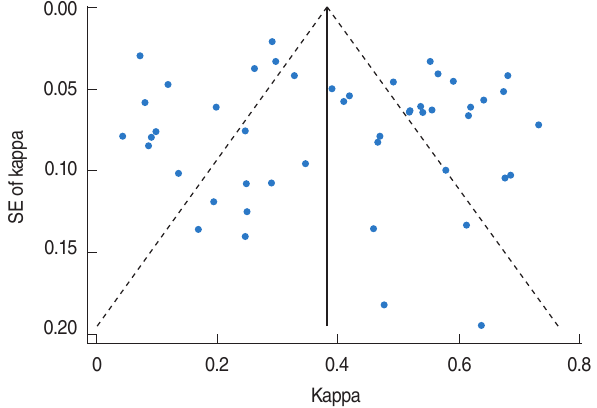
Figure 3. Funnel plot, using data from included studies in meta- analysis, with kappa displayed on the horizontal axis and SE (kap- pa) on the vertical axis; symmetrical plot shows the absence of pub- lication bias. SE, standard